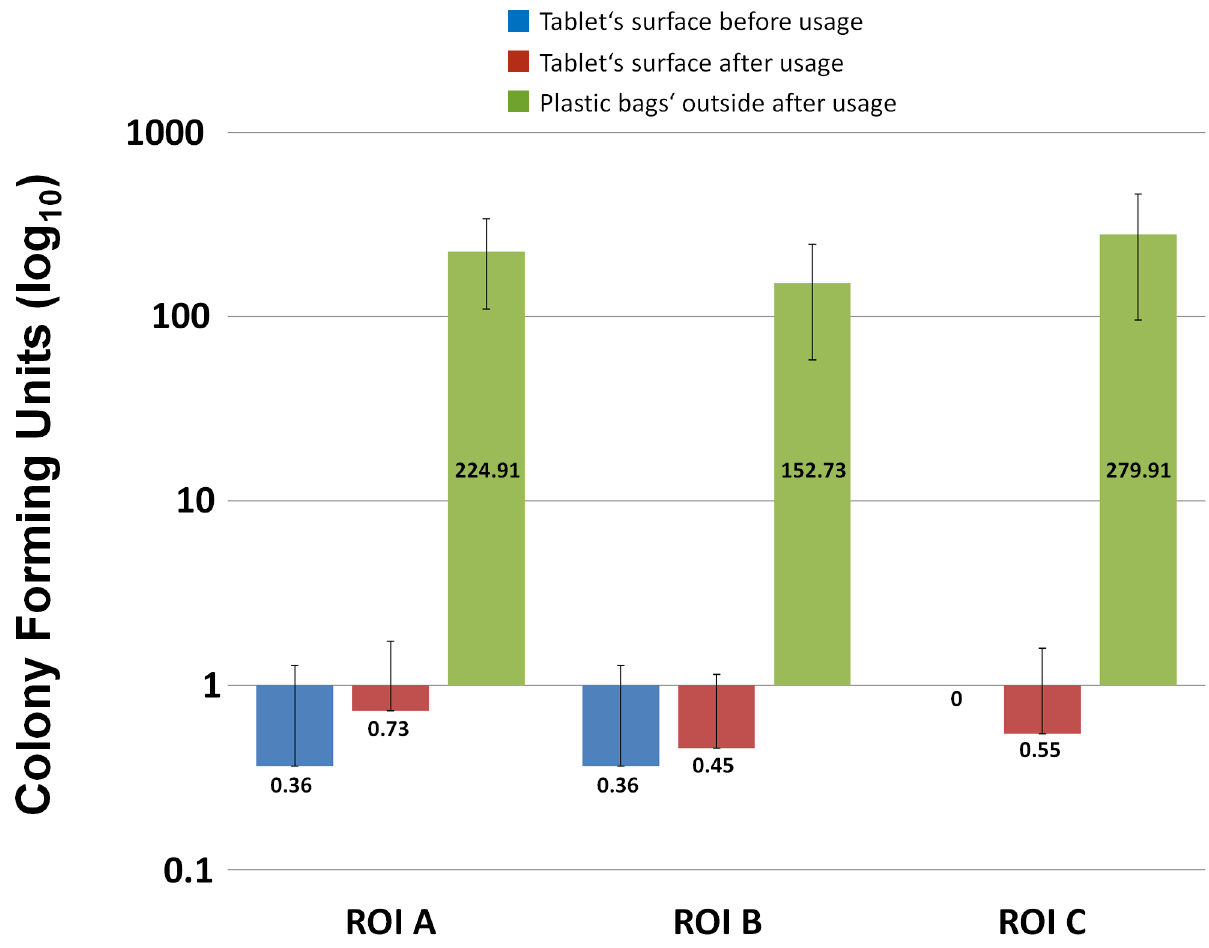
Figure 3. Microbial contamination of the surface of the tablet and of the outside of the used plastic bags. Logarithmic presentation of the mean microbial contamination (colony forming units, CFUs) of the surface of the tablet computer before the initial and after the final use of each day and of the outside of the plastic bags of each day. Mean values 6 standard deviations are shown. Samples were taken from three defined regions of interest (ROIs; ROI A = central touchscreen, ROI B = home button and its adjacent area, ROI C = upper central